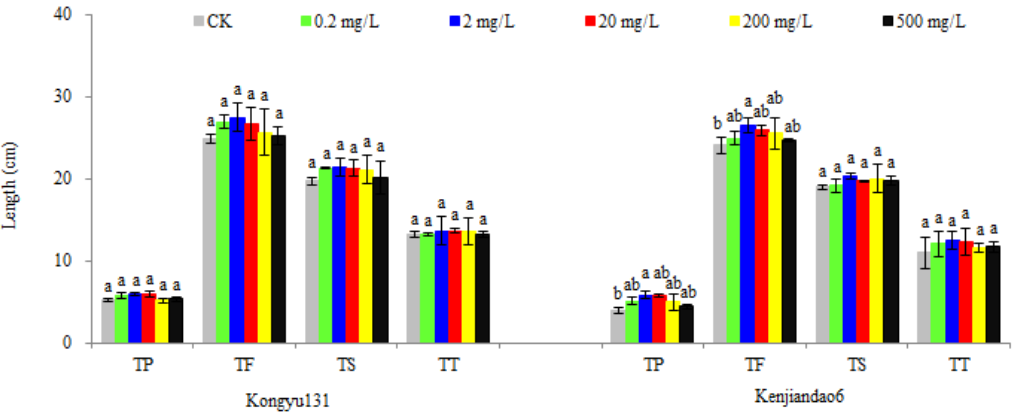
Figure 5. Effects of diethylaminoethyl hexanoate (DA-6) on internode length and take out the length of panicle at booting in both cultivars. TP — take out the length of panicle; TF — top first internode length; TS — top second internodes length; TT — top third internodes length. The letters above the columns indicate significant differences ( p < 0.05).